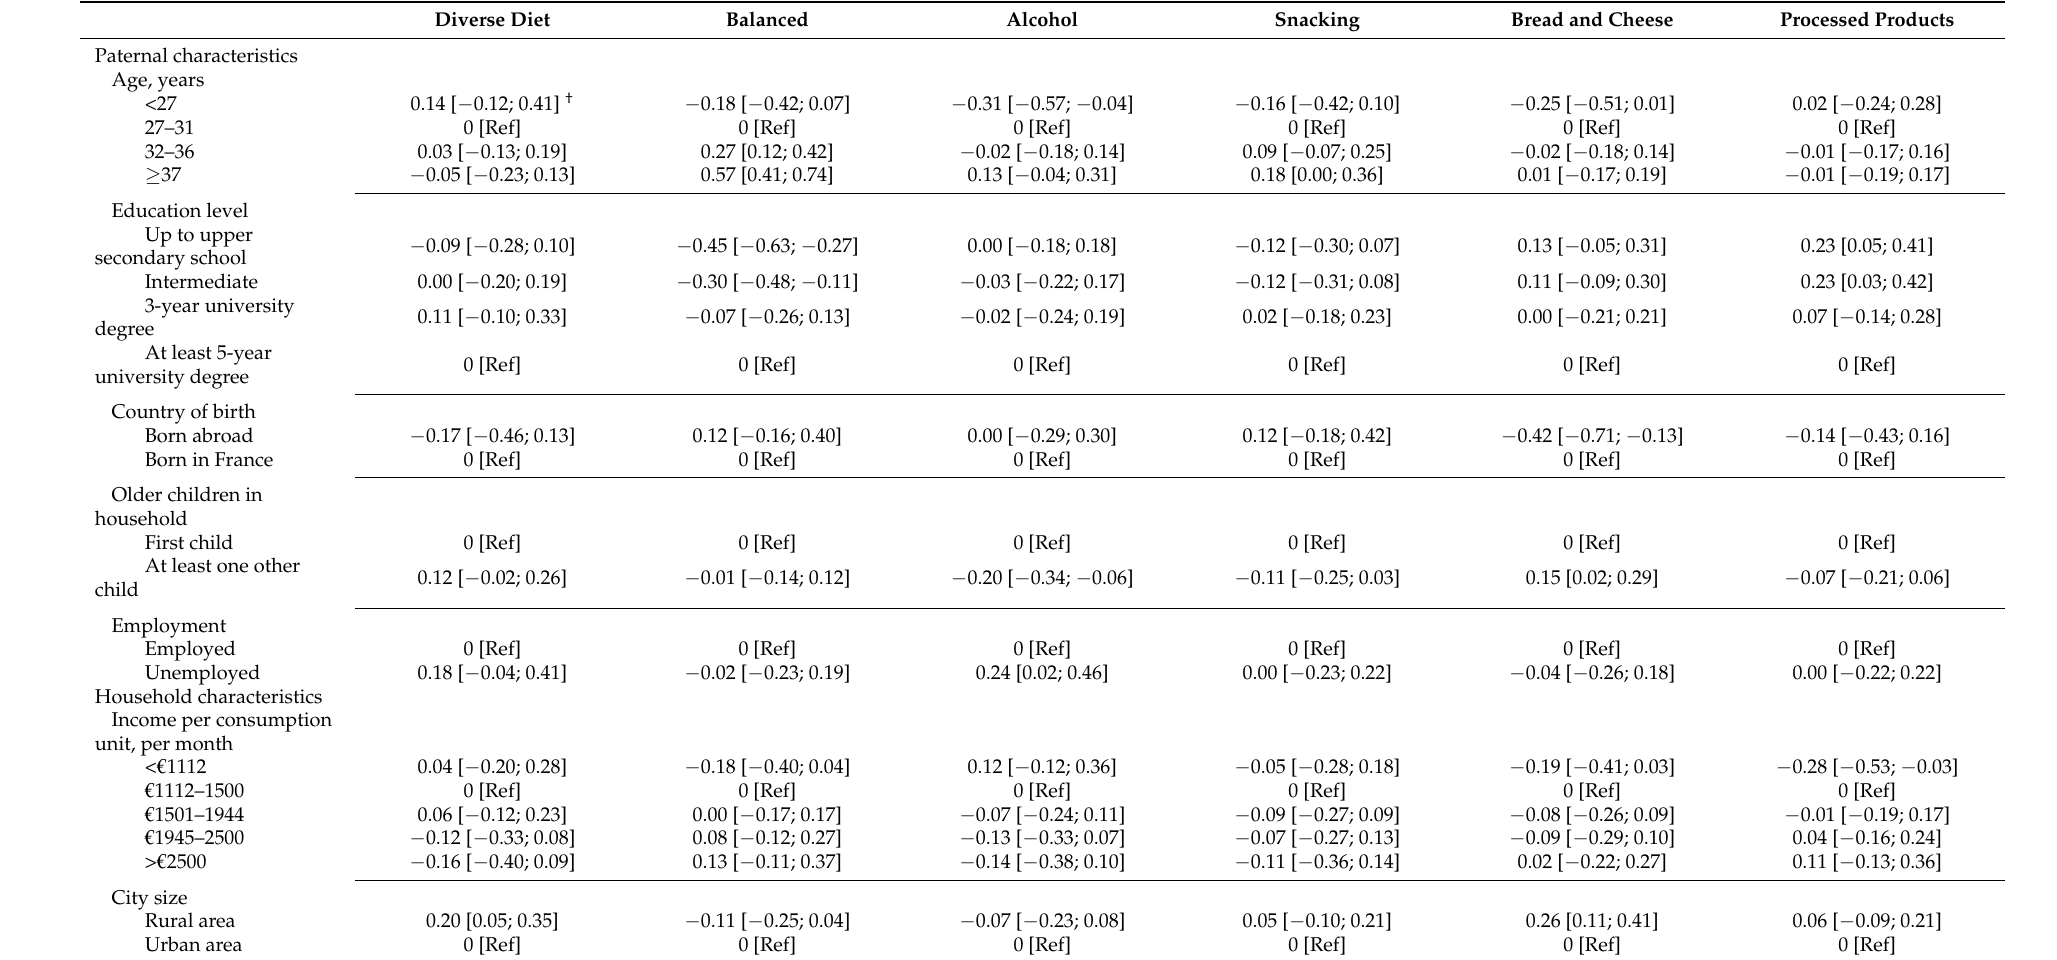
Table 2. Multivariable associations between paternal and household characteristics and paternal diet ( n = 998): the ELFE study, 2011. Diverse Diet Balanced Alcohol Snacking Bread and Cheese Processed